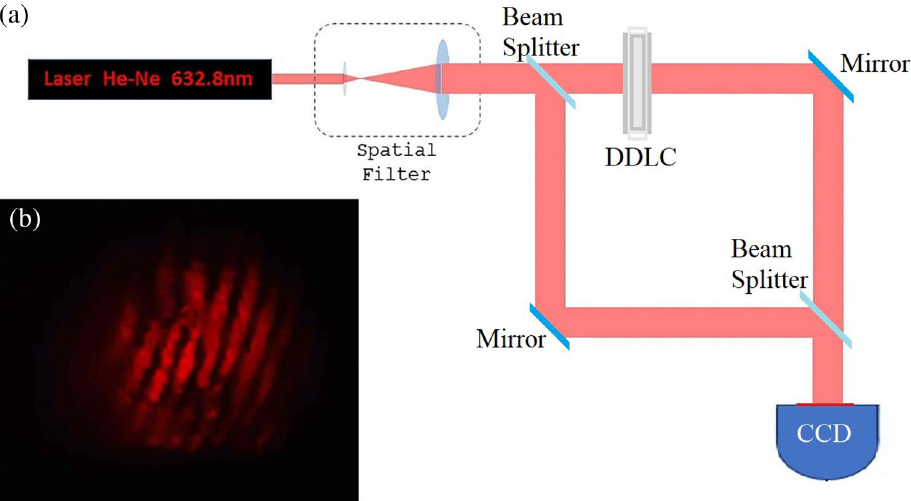
Figure 11. ( a ) The interference set-up to detection of topological charge of created vortex beam, ( b ) interference pattern shows the Fork grating with p = 1.